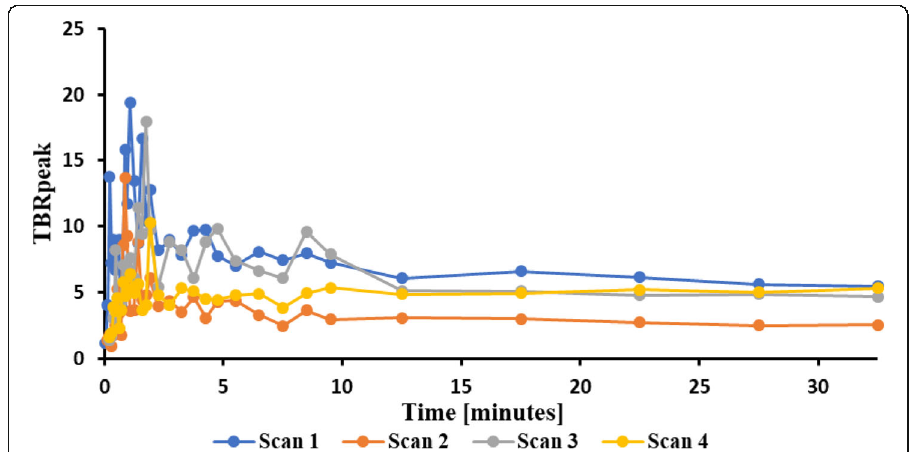
Fig. 3 Graph showing cerebral tumour TBR peak as a function of time for all four scans. TBR peak values for each of the four scans peak within the first 2 min, followed by a decrease and a steady-state after 10 min